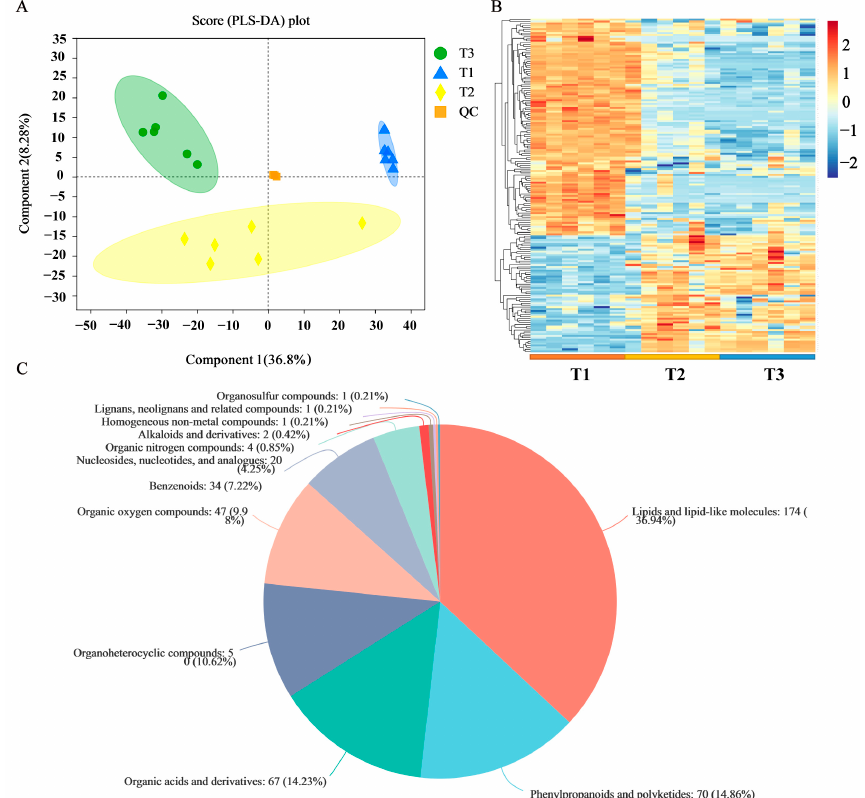
Figure 6. Metabolite annotation information of SYQ roots. ( A ) PLS-DA of metabolites identified in developmental stages. ( B ) Heatmap of all expressed metabolites at three developmental stages. The color indicates the level of relative content of each metabolite, from blue (low) to red (high). ( C ) Classification of overall metabolites.